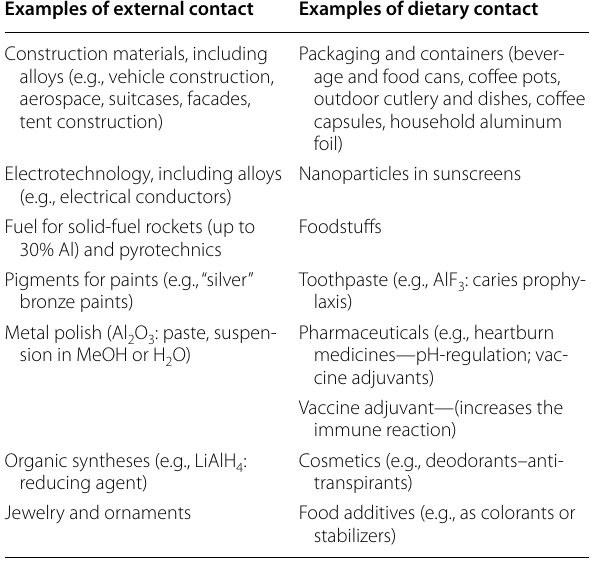
Table 1 Aluminum—external and dietary